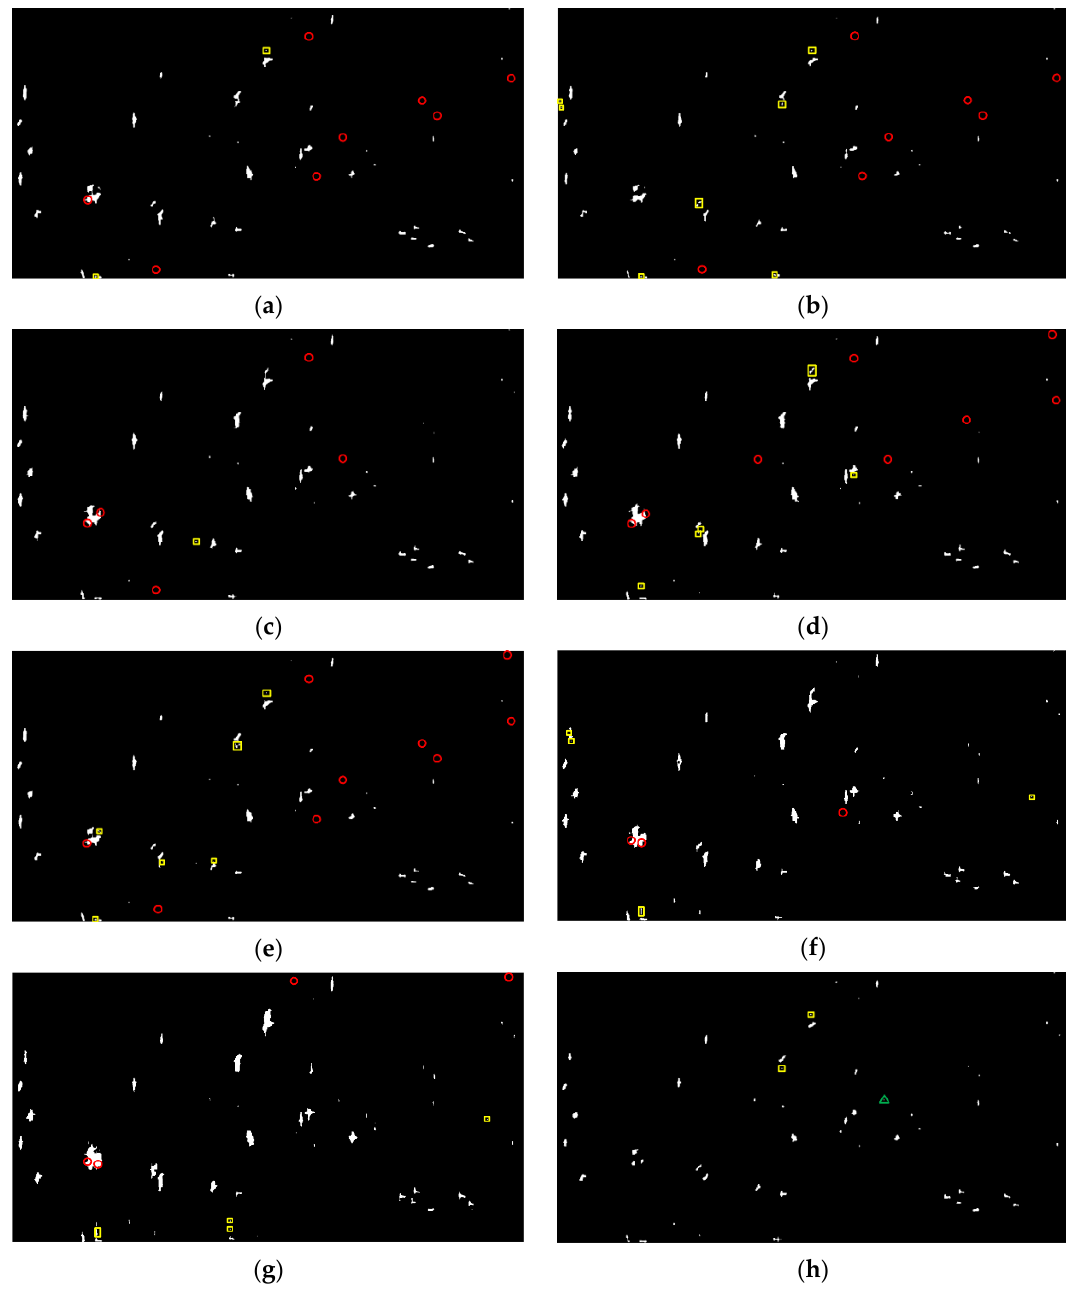
Figure 3. Ship detection results on GF3 data. ( a – h ) The PMS, PNF, Pt-Ps, RS, SPAN, DBSPc, VC-CR, and the proposed method, respectively. The red circles, yellow rectangles, and green triangles outline the missed targets, false alarms, and barely visible detected ships, respectively.